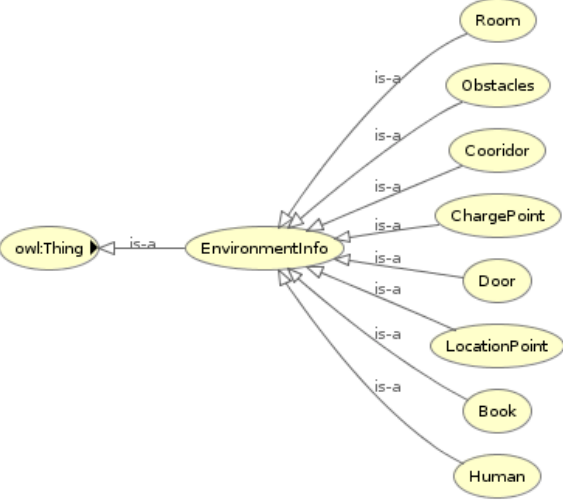
Figure 6. The environment ontology shown in Protégé.